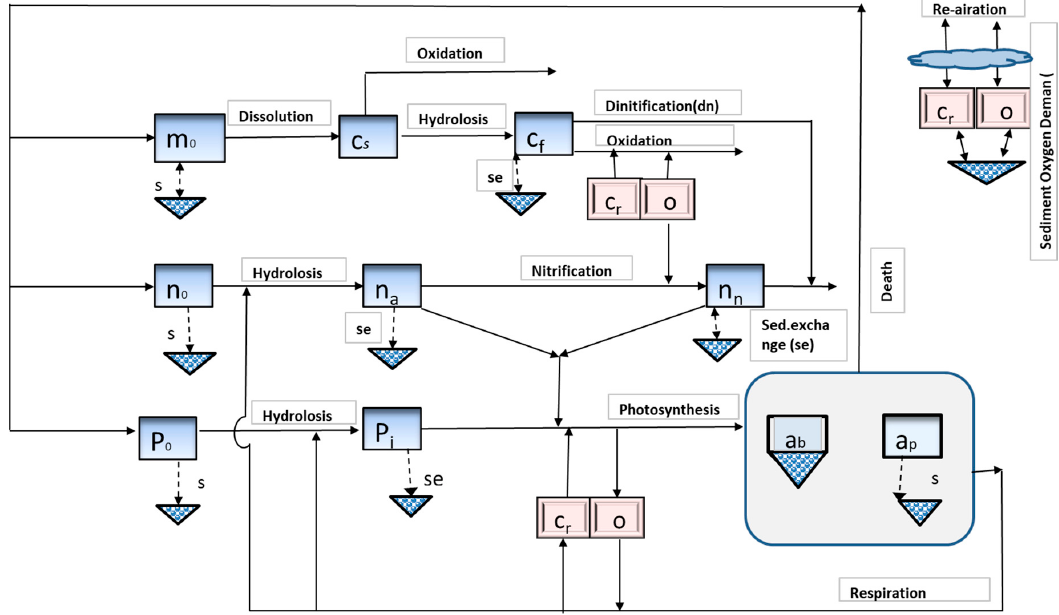
Figure 3. QUAL2Kw graphical illustration of water quality parameters: o-dissolved oxygen, ap-phytoplankton, ab-algae (bottom algae), no-nitrogen (organic), Mo-detritus, Cf-CBOD fast, Cs-CBOD slow, Cr-inorganic carbon, nn-nitrite nitrogen, na-ammonium nitrogen, pi-inorganic phosphorus, and po-organic phosphorus.